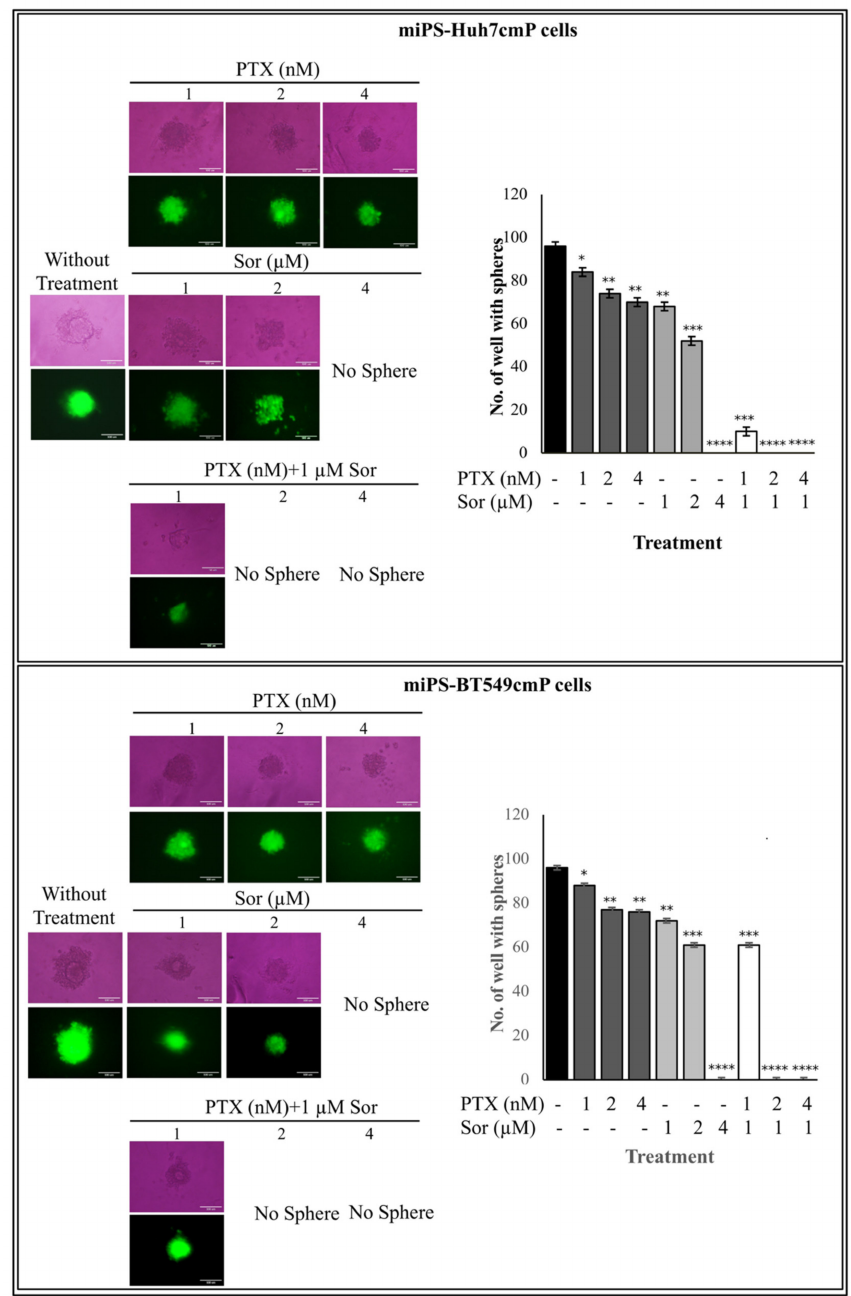
Figure 4. Sphere formation assay from mips-Huh7cmP and mip-BT549cmP cells. Sphere formation potential assessed after cultivation in serum-free cell culture medium. After 7 days incubation, the number of wells with at least one sphere with diameter ≥ 50 um was counted. The asterisks represent the mean expression levels; * p < 0.05; ** p < 0.001; *** p <